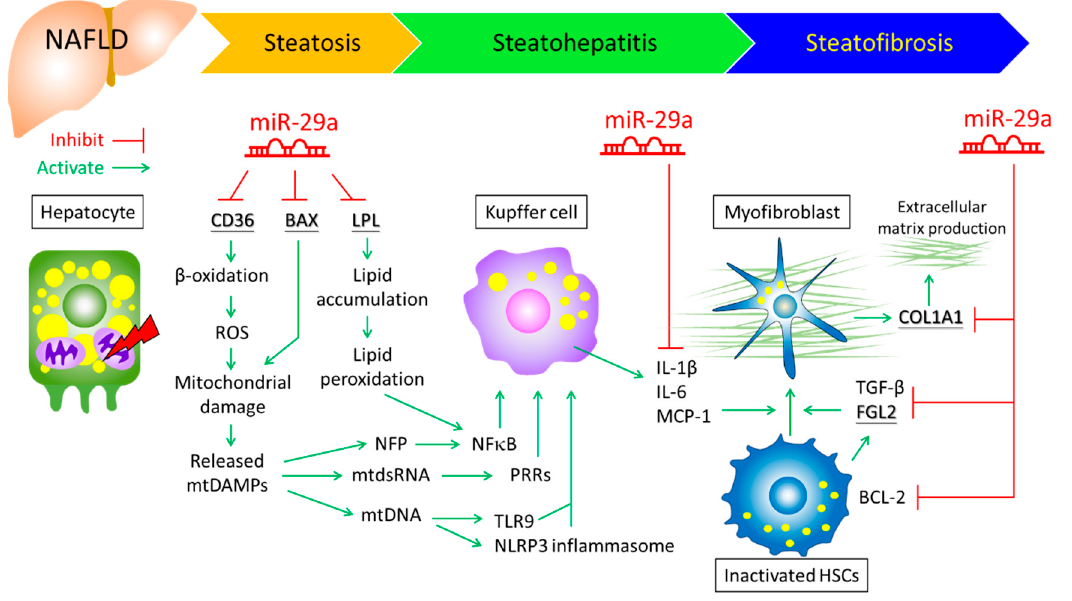
Figure 1. Role of miR-29a on modulating hepatic mtDAMPs release, lipid metabolism, inflammation, and fibrogenic signaling in the pathogenesis of NAFLD. Underlined genes represent miR-29a targets. BAX, Bcl-2-associated X protein; FGL2, fibrinogen-like 2; LPL, lipoprotein lipase; mtDAMPs, mitochondrial danger-associated molecular patterns; mtDNA, mitochondrial DNA; mtdsRNA, mitochondrial double-stranded RNA; NFP, N-formyl peptides; PRRs, pattern recognition receptors; NLRP3, NOD-like receptor family pyrin domain containing 3; TLR9, toll-like receptor 9.